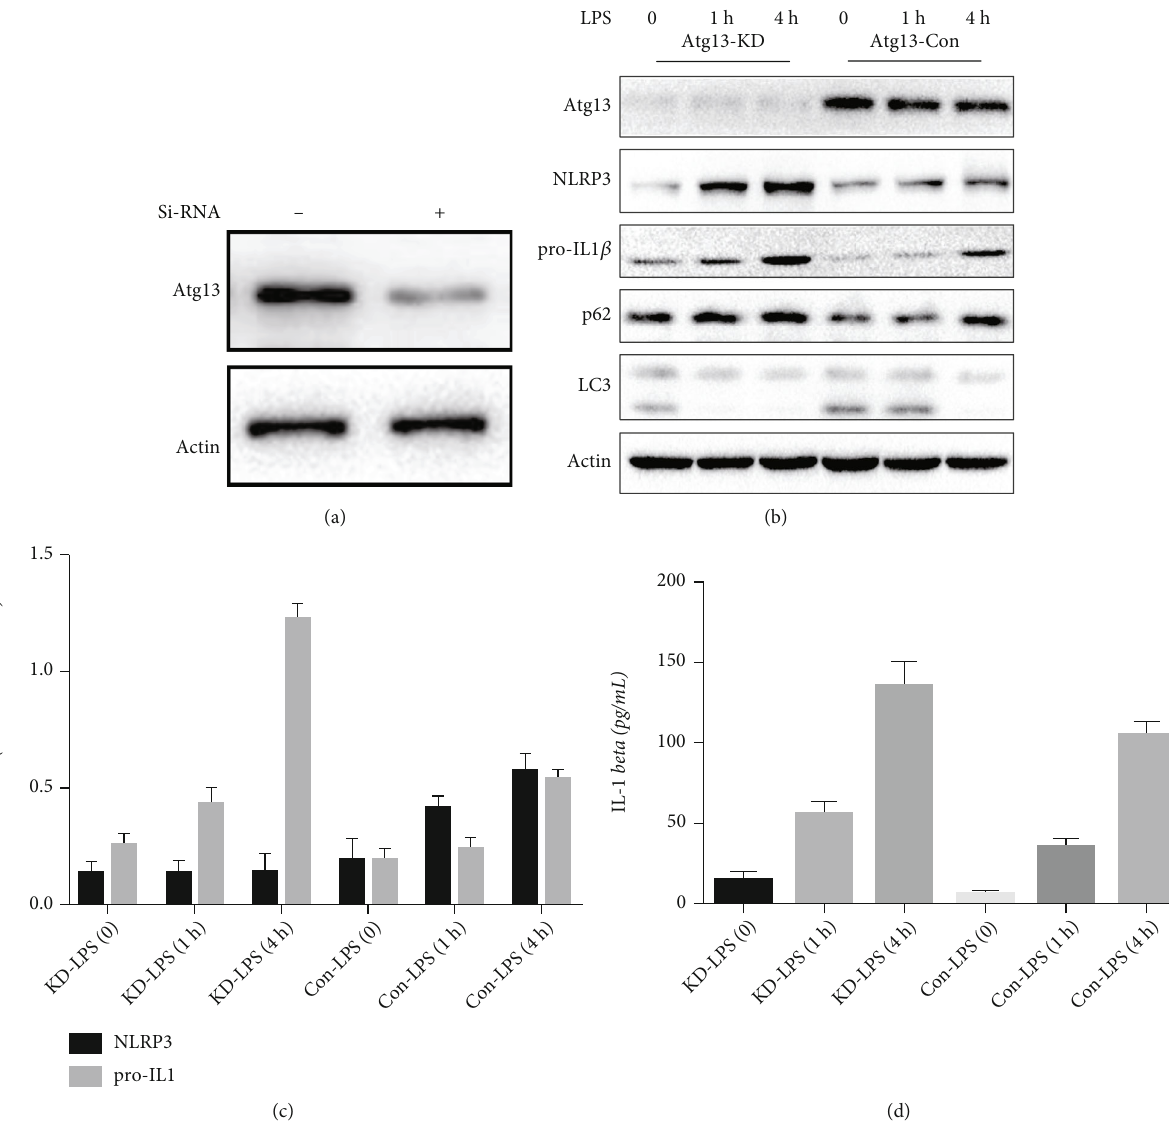
Figure 6: Decrease of Atg13 inhibits autophagy and promotes LPS-induced in fl ammatory responses in LX2 cells. (a) Atg13 siRNA successfully decreased expression of Atg13. (b – d) Decrease of Atg13 inhibited autophagy and promoted LPS (1 μ g/mL, 0-4 h)-induced NLRP3 in fl ammasome activation and IL-1 β